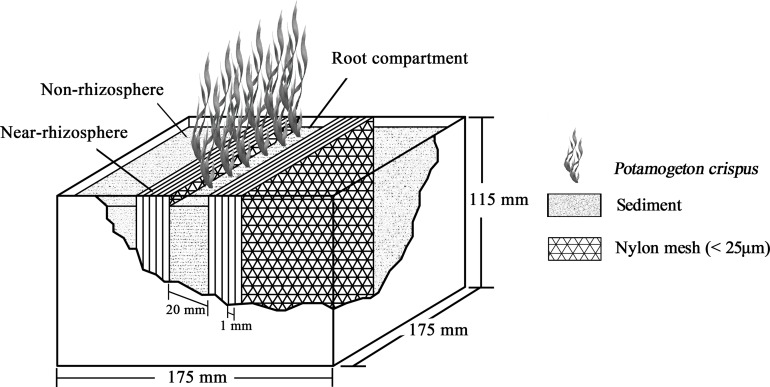
Schematic diagram of the rhizobox (175 × 175 × 115 mm) used for cultivation of submerged P. crispus (modified from He et al., 2005).